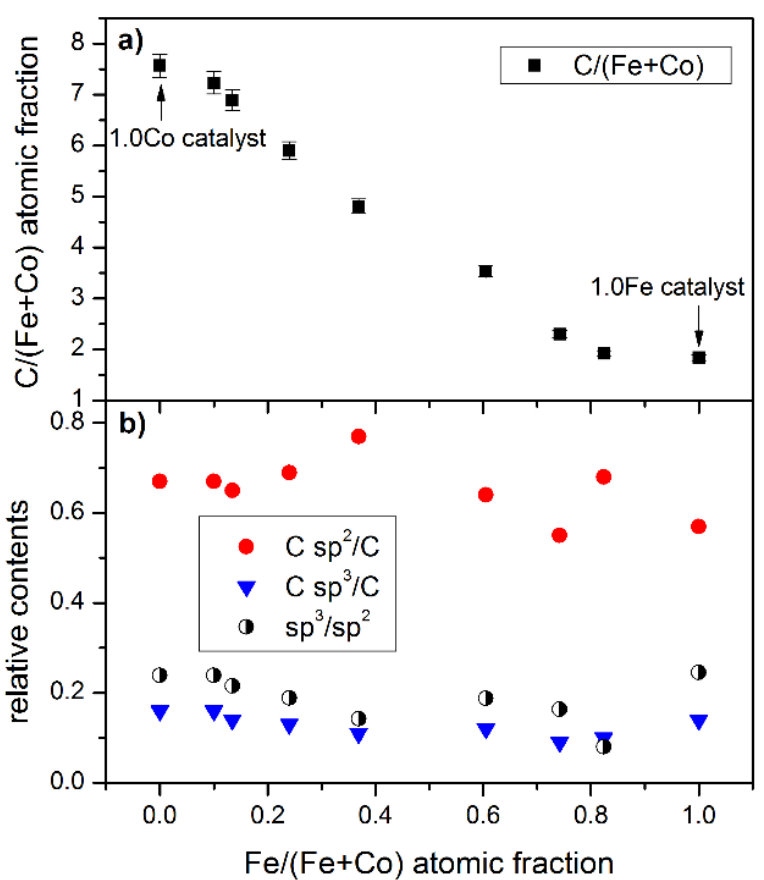
Figure 6. The chemical structure of the plasma-deposited Fe-Co nanocomposites based on XPS and EDX analysis: ( a ) the atomic fraction of carbon calculated as C/(Fe + Co) and ( b ) relative contents of particular carbon species based on C 1s spectrum bands as functions of Fe/(Fe + Co) fractions.